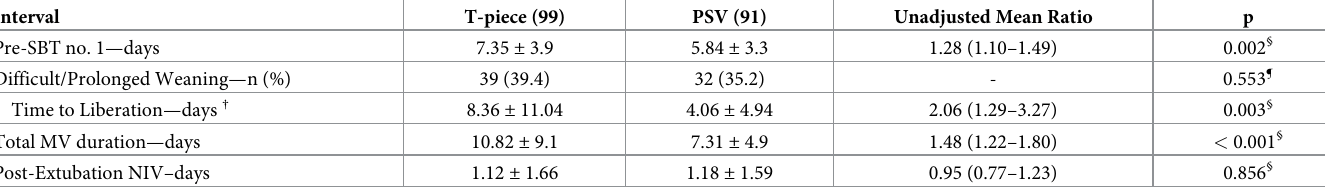
Table 3. Mechanical ventilation stages.